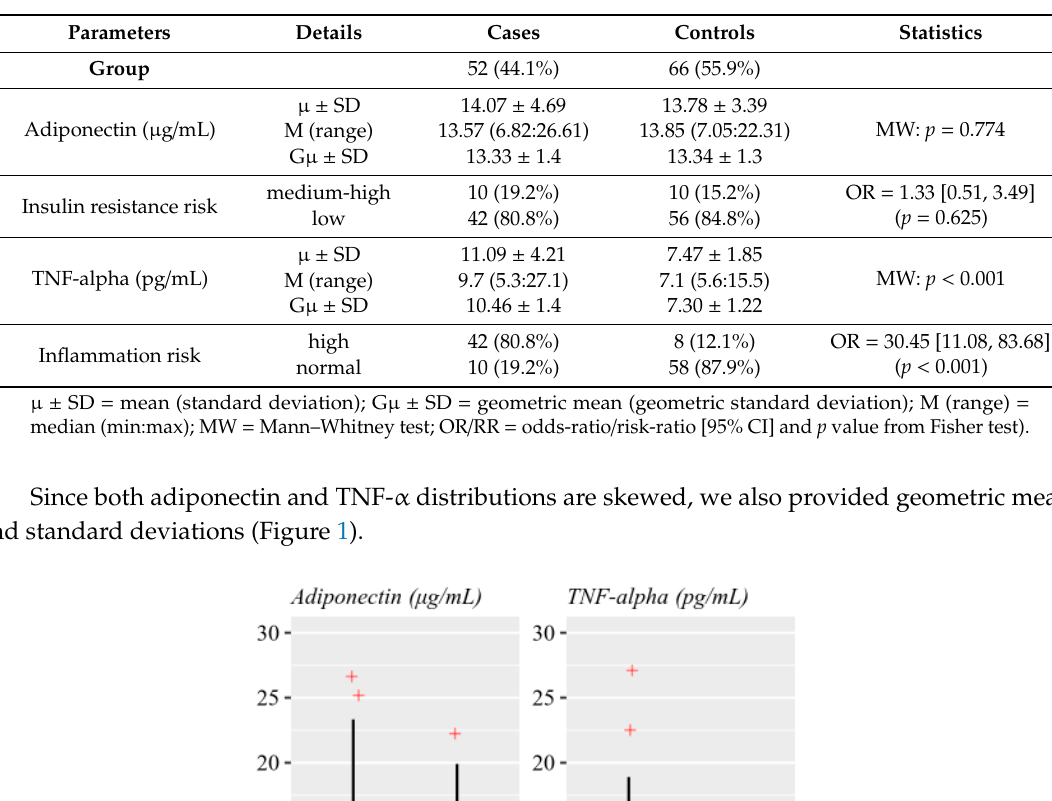
Table 2. Adiponectin ( μ g/mL) and TNF- α (pg/mL) values by group, as well as by risk of insulin resistance. Table2. Adiponectin( µ g / mL)andTNF- α (pg / mL)valuesbygroup, aswellasbyriskofinsulinresistance.